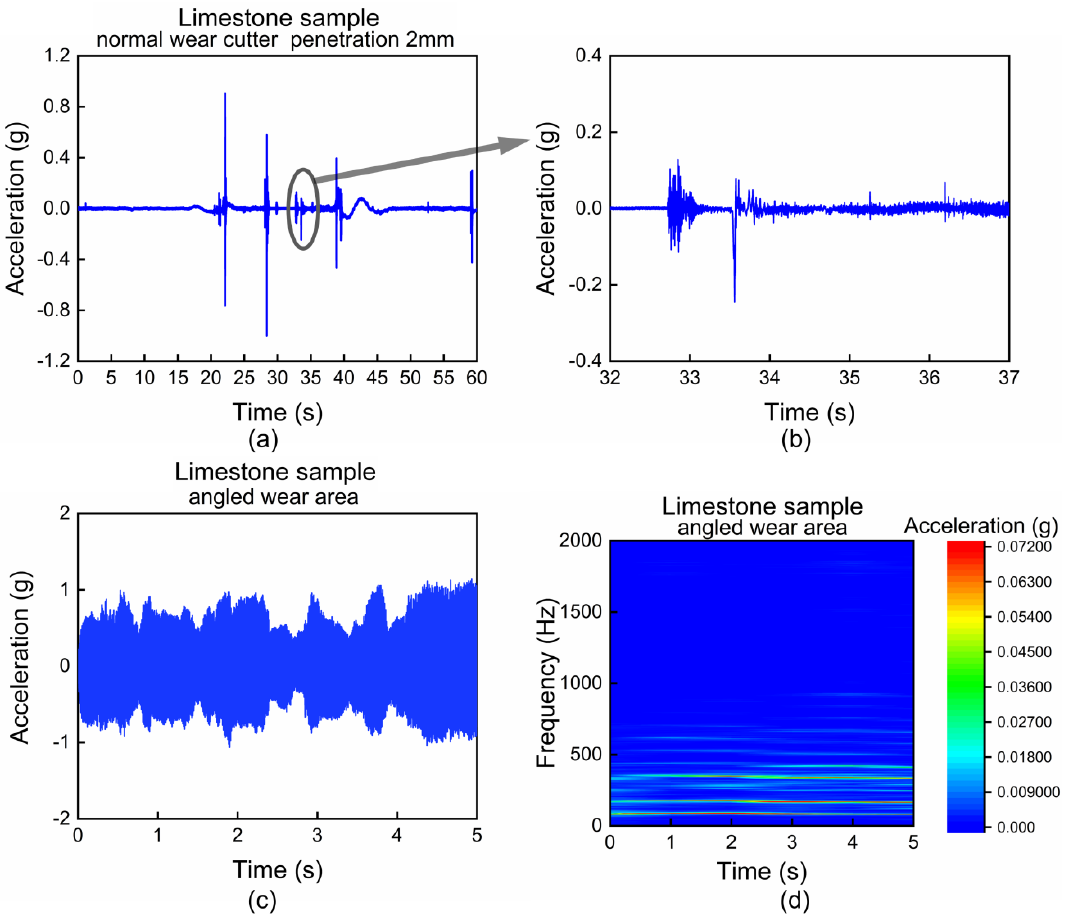
Figure 7. Limestone sample, vibration characteristics: ( a ) normal wear cutter, penetration 2 mm, 60 s time domain waveform; ( b ) normal wear cutter, the waveform in selected area, no periodic characteristics; ( c ) angled wear failure cutter, angled wear area, time domain waveform; ( d ) angled wear failure cutter, angled wear area, frequency – domain characteristics.